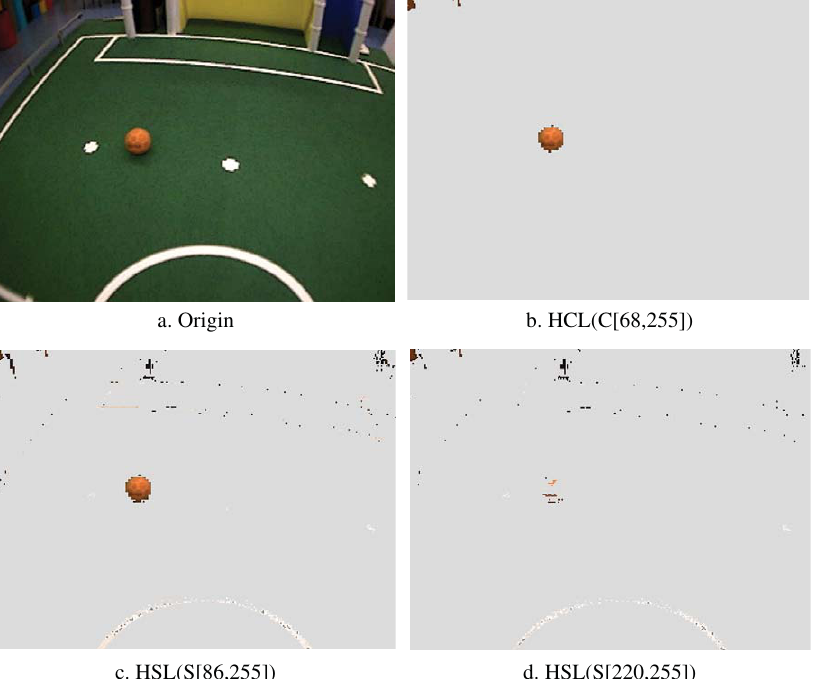
Fig. 12. Colour segmentation results of orange colour.